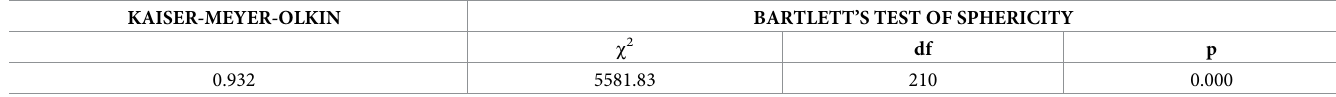
Table 1. Factor analysis: KMO and Bartlett’s Test.